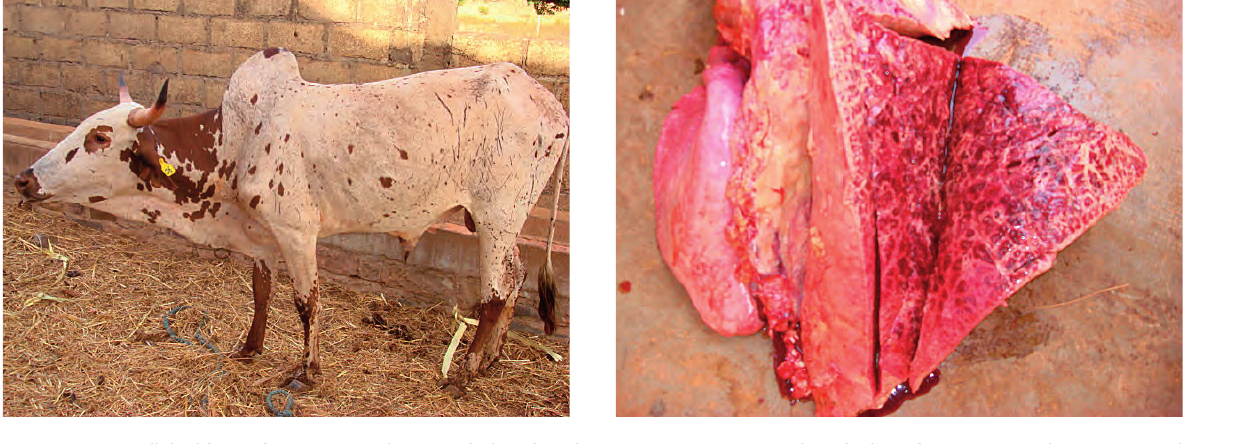
FIG. 1 Acute clinical form of CBPP. Note the extended neck and abducted fore limbs indicative of respiratory dis tress Source: M. Niang; FAO Project (2008)-LCV, Bamako- Mali